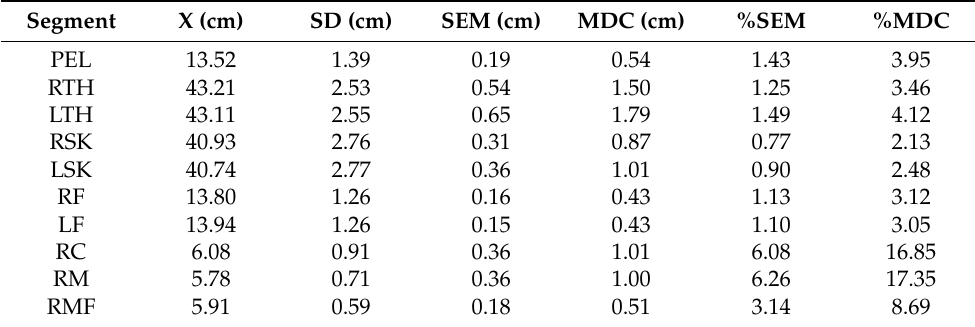
Table 4. Reliability of lower limb segments length. Mean (X), standard deviation (SD), standard error measurement (SEM), minimal detectable change (MDC), and their percentage of the mean from eight evaluators.